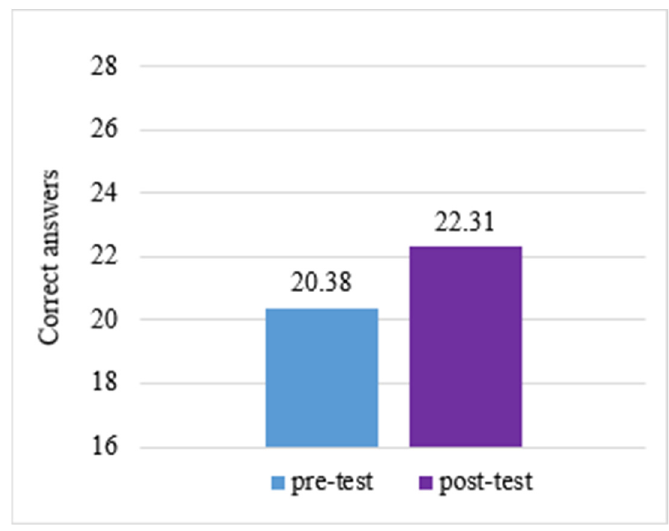
Figure 12. Third grade students’ mean grade in the pre-/post-test.